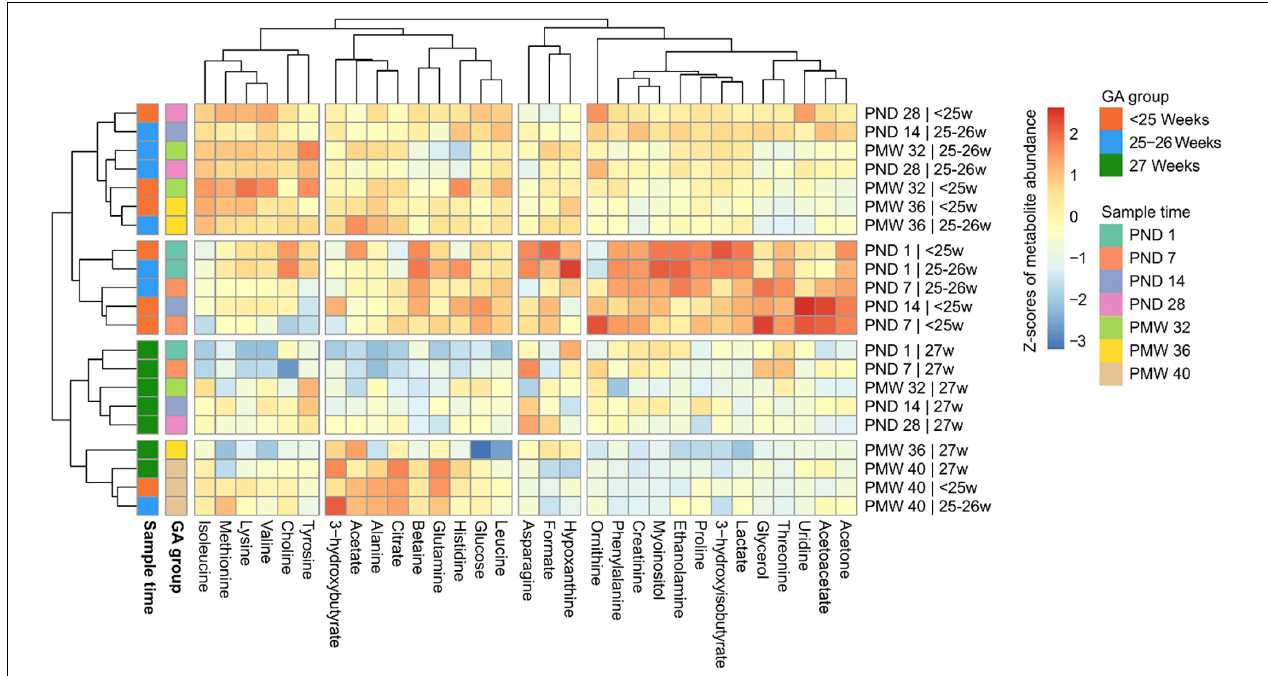
FIGURE 2 | Heatmap of metabolite levels over the study period stratified by gestational age (GA) at birth: < 25 weeks, 25–26 weeks, or 27 weeks. Each metabolite was scaled using the mean value and standard deviation and centered at 0. Intensities from blue to red display relative metabolite levels in standard deviations. Both rows and columns have been hierarchically clustered based on metabolite abundances at specified time points for each GA group. Thus, metabolites that show similar abundance patterns across the study period group together vertically, and time points for each GA group that show similar metabolite abundance patterns group horizontally. Breaks in the heatmap indicate clusters from the dendrograms; the number of clusters was manually specified. PND, postnatal day; PMW, postmenstrual